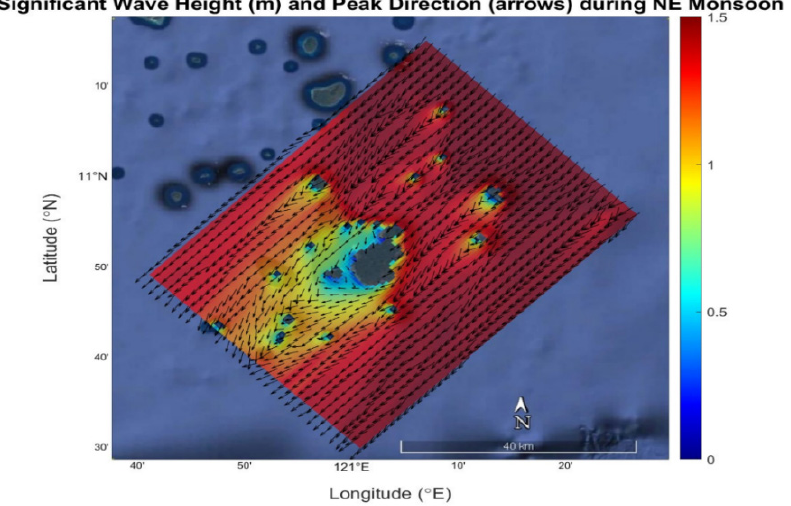
Figure 18. H s (m) and peak wind directions during northeast monsoon season. Figures 19–21 show the wave model results for the H s , T p and P d model for southwest monsoon season, respectively, and stations A–F have an average H s = 0.52 m, T p = 3.37 s and